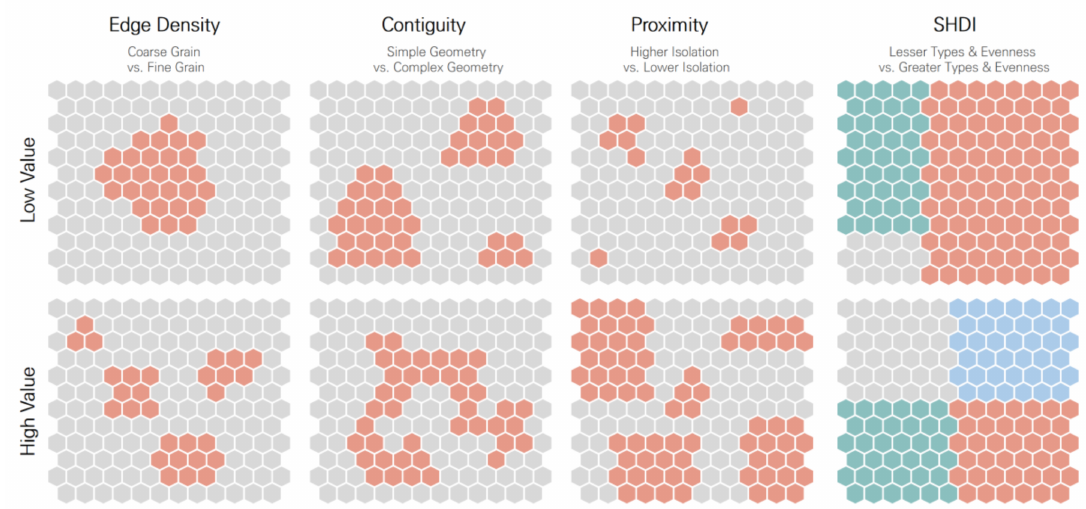
Figure 2. An intuitive interpretation of landscape ecology metrics (colored pattern refers to different land cover types of